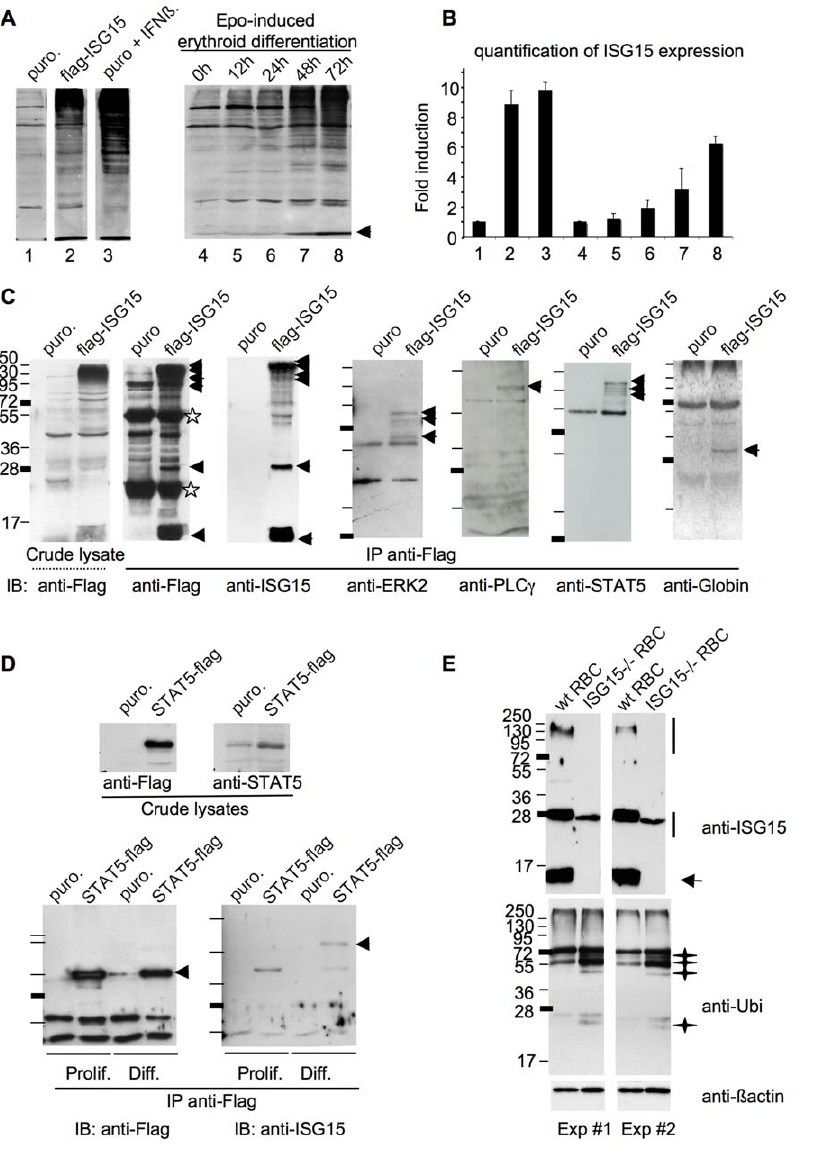
Figure 5. Identification of several ISGylation substrates in erythroid cells and increased ubiquitination in ISG15 -/- RBCs. ( A ) Proliferating erythroblasts were left either untreated (1), or stimulated with IFNß (100 U/ml) for 24 h (3), or induced to differentiate for 72 h (lane 4 to 8). Cells were lyzed according to size and number and ISG15/ISGylation level was compared by western blotting to the level of ISG15/ISGylation present in proliferating Flag-ISG15-expressing p53 -/- erythroid cell line. The arrow points to ISG15 band ( B ) Quantification of ISG15 level in independent western blot experiments. ( C ) Proliferating control and Flag-ISG15-expressing p53 -/- erythroid cell line were lysed and ISGylated proteins searched after a Flag immunoprecipitation. Anti-Flag detect ISG15-Flag and ISGylated proteins (arrow heads) in the crude lysates (dashed line) and are found enriched after the immunoprecipitation (plain line bar). Stars point to light and heavy chains of immunoglobulin. For the detection of ISGylated Globins, cells were induced to differentiate for 72 hours in order to induce globin expression. ISGylated proteins are indicated by arrowheads. Normal unmodified molecular weight of the proteins are: ERK2 (42kDa), PLC c (150kDa), STAT5 (90kDa), Globin (13kDa). For ERK2 and STAT5 detection, cell lysates were run on a 10% acrylamide gel, for ISG15 and Globins detection on a 15% acrylamide gel and for PLC c on a 8% gel. ( D ) Proliferating or 48 hours-differentiating control and STAT5-Flag-expressing p53 -/- cell line were lysed and analyzed for exogenous STAT5 expression either using a Flag (upper left panel) or a STAT5 antibody (upper right panel). Note the modest increase in the total amount of STAT5 induced by the expression of STAT5-Flag. ISGylated STAT5 was searched after a Flag immunoprecipitation followed by either a Flag (bottom left panel) or an ISG15 western blot analyses (bottom right panel). Extracts were run on a 7% acrylamide gel. ( C ) Western blot analysis of RBC extracts from WT and ISG15 -/- mice using a 15% acylamide gel. ISG15 expression and ISGylation were analysed using anti-ISG15 antibody (top panel), ubiquitination was monitored using anti-ubi antibody (intermediate panel) and anti- b -Actin was used as a loading